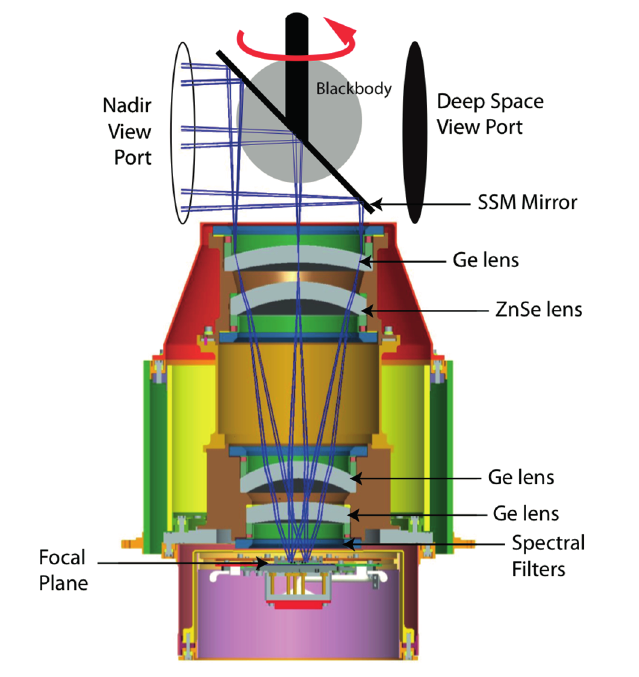
Figure 1. TIRS optical diagram. The SSM mirror rotates between the nadir viewport, blackbody and deep space viewport to provide calibration at least once an orbit.